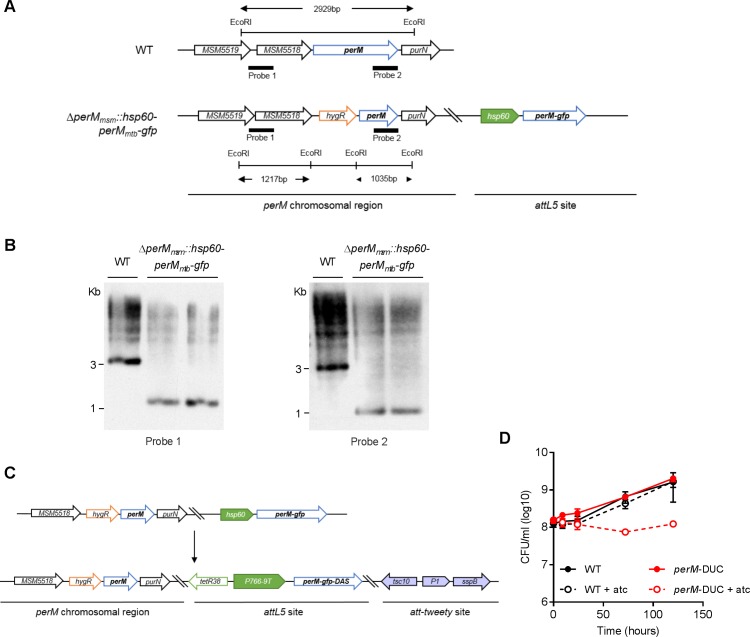
Construction and characterization of a PerMmsm depletion mutant (perM-DUC).(A) Map of perMmsm genomic region in WT and the att-site mutant ∆perMmsm::hsp60-perMmtb-gfp. To construct the att-site mutant, we first generated a merodiploid strain by integrating a copy of perMmtb-gfp into the attL5 site expressed under the constitutive hsp60 promoter. Next, we replaced the first 971 bp of perMmsm with a hygromycin resistance cassette using homologous recombination. (B) Southern blots of genomic DNA from WT and two att-site mutant candidates after digestion with EcoRI and probed with probe 1 (left) and probe 2 (right) as marked in (A). Bands at around 1 kb from the two candidates showed the successful deletion of perMmsm. (C) Schematic of constructing the perM-DUC mutant from the perM att-site mutant. We first replaced the construct in the attL5 site of ∆perMmsm::hsp60-perMmtb-gfp with DAS tagged perM-gfp expressed under the P766-9T promoter and controlled by reverse tet repressor. A construct that expresses the SspB adaptor protein was integrated into the att-tweety site. (D) Bacterial titers of WT and perM-DUC cultured in standing 7H9 medium with and without atc. At the indicated time points, samples were collected and CFU recovered on 7H10 agar that contains 0.4% charcoal to remove carryover of atc. Data are means ± SD of three replicates and representative of two independent experiments.